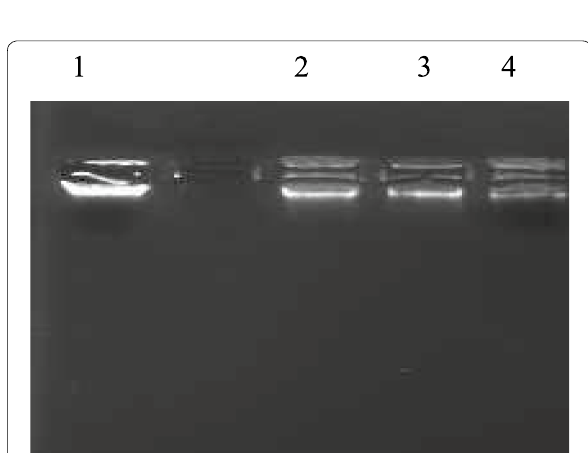
Fig. 3 Photograph showing the effects of synthetic molecules on calf thymus DNA. Lane 1: Untreated DNA, lane 2: 12a , lane 3: 12b , lane 4: